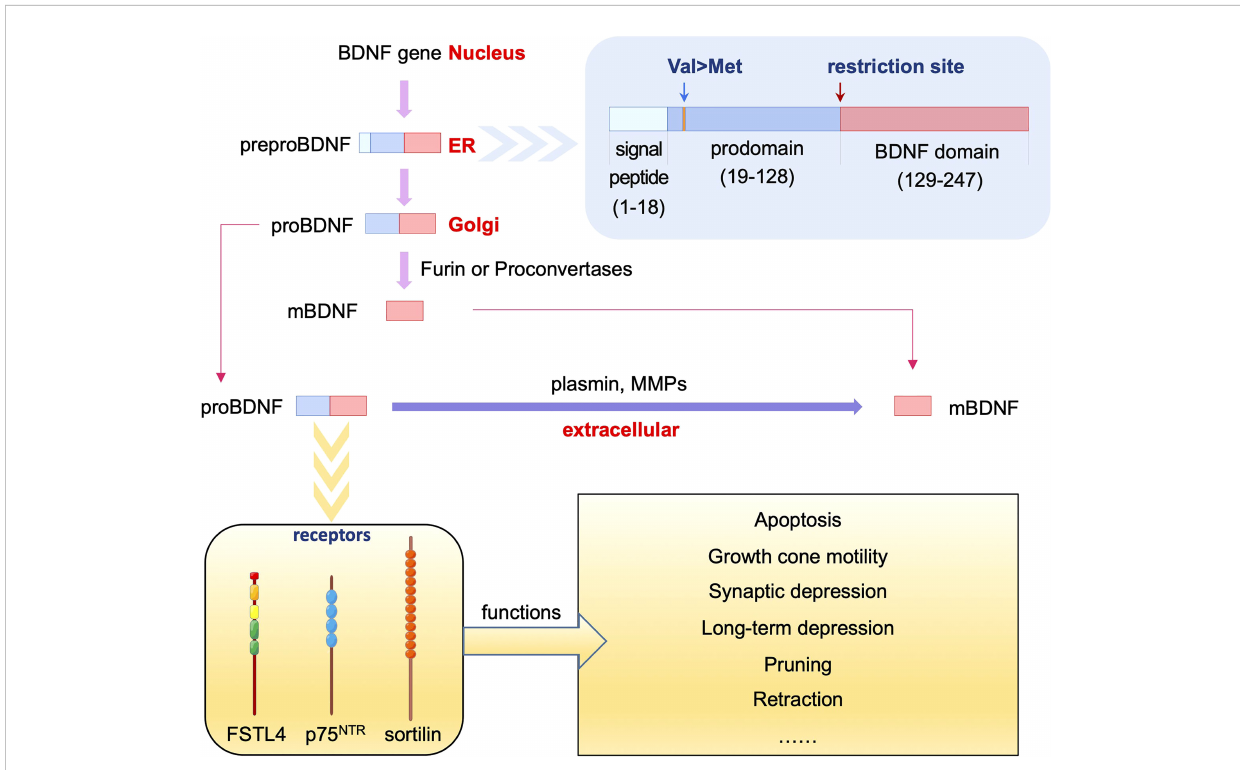
FIGURE 1 Processing and function of proBDNF and its receptors. The BDNF gene produces preproBDNF protein in the ER, which is processed to proBDNF in Golgi. ProBDNF may be cleaved into mBDNF intracellularly by furin or proconvertases, or extracellularly by plasmin or MMPs. ProBDNF binds to p75 NTR , sortilin or FSTL4 to exert different effects including apoptosis, growth cone motility, synaptic depression, long-term depression, pruning, retraction and other